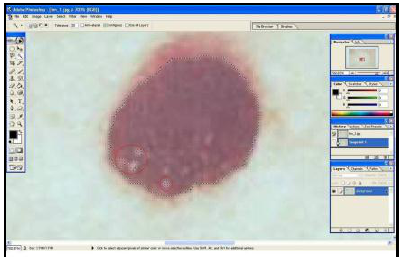
Figure 10. Pixels which are not included at result of Magic Wand tool process